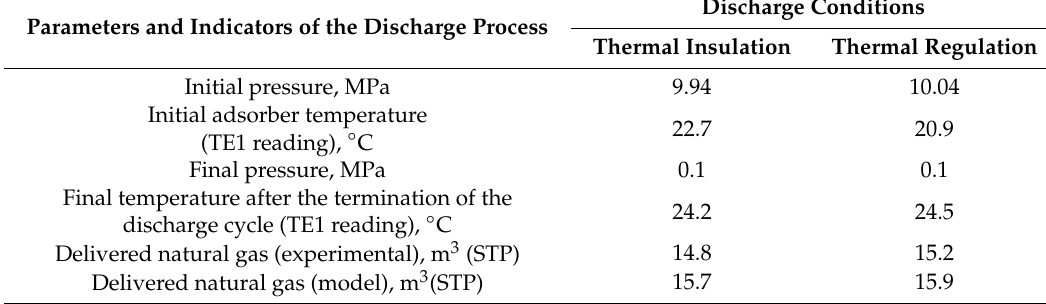
Table 3. Experimental and modeling data on the amount of delivered natural gas during the discharge process under the conditions of thermal insulation and thermal